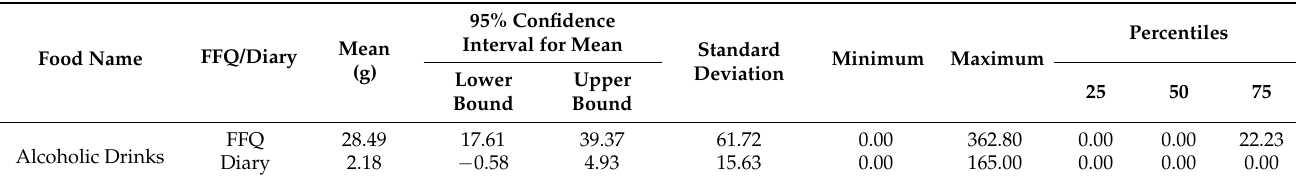
Table A3. Descriptive of the total study population (mean ± standard deviation; Min. P25. P50. P75 and Max; 95% confidence interval). Descriptive males; n =